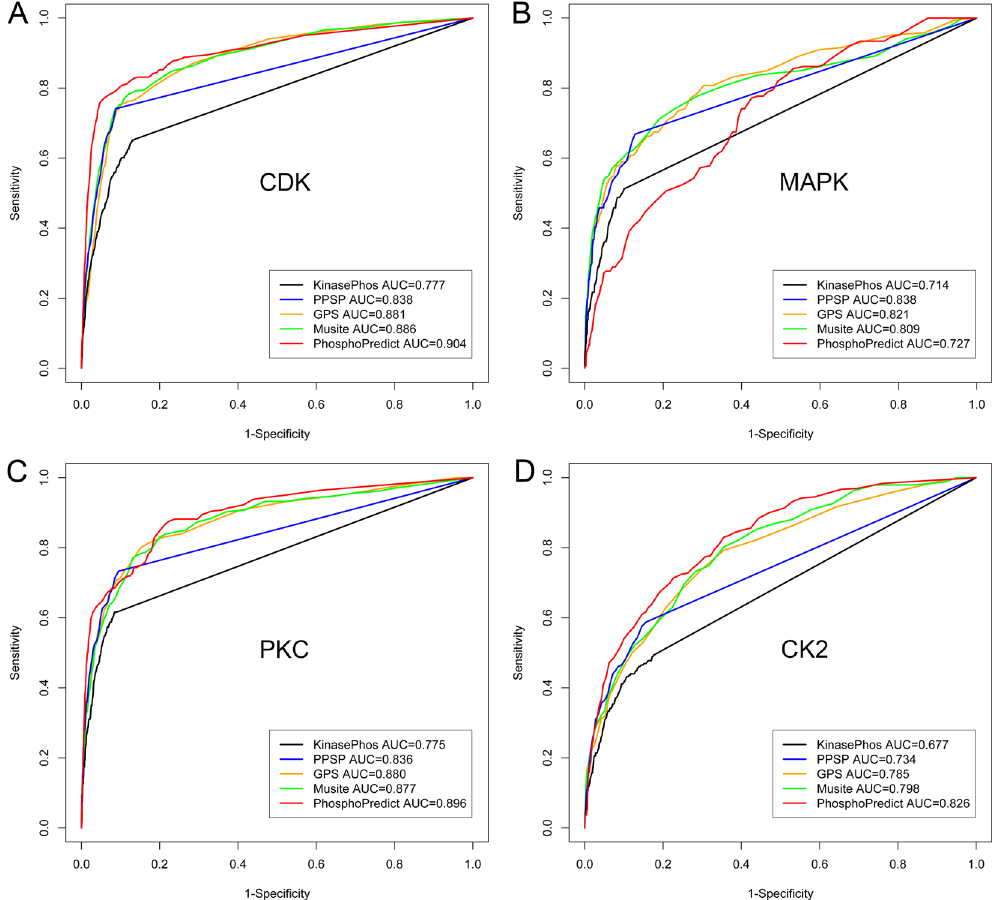
Figure 4. Comparative phosphorylation site prediction. ROC curves for kinase-specific phosphorylation site prediction between PhosphoPredict and the four currently-available tools, including KinasePhos, PPSP, GPS, and Musite. Data represent ( A ) CDKs, ( B ) MAPKs, ( C ) PKC, and ( D )